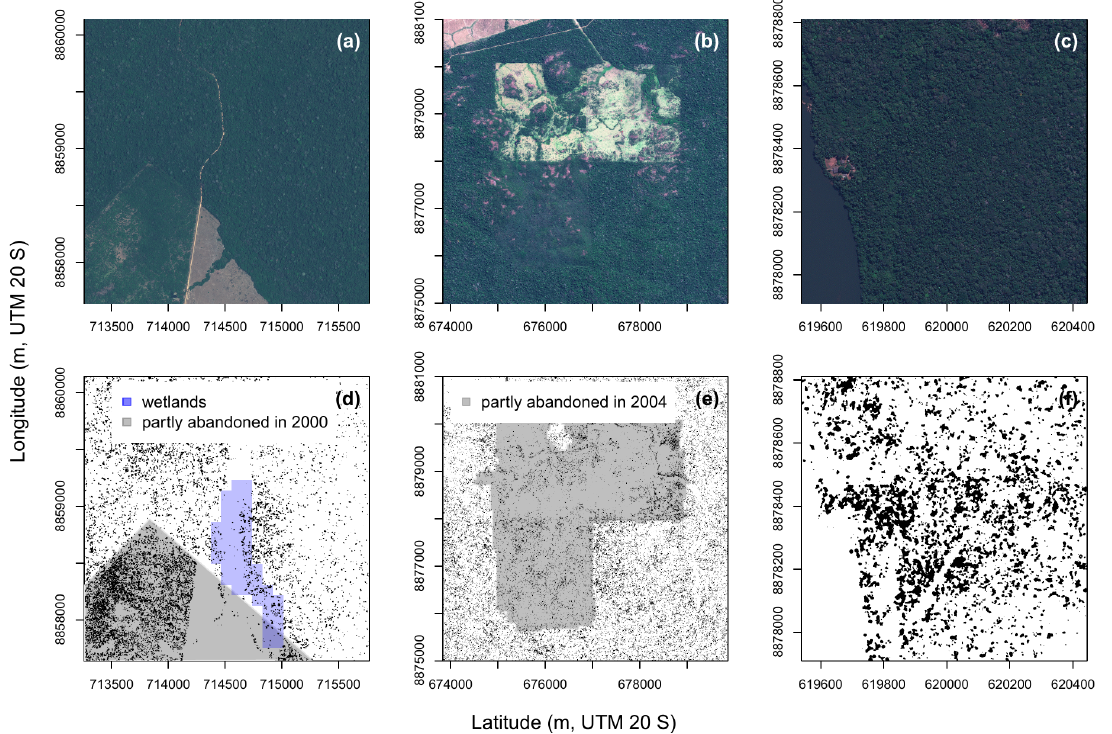
Figure 6. RGB image and distribution of canopy palms in 3 scenarios of forest degradation. Region 1 ( a , d ) was abandoned in 2000 after clear-cut before 1988 and maintained more than 10 years as a pasture, region 2 ( b , e ) was abandoned directly after clear-cut in 2002/2003 and region 3 ( c , f ) has no history documented of clear-cut since 1988 but had the presence of a human settlement. See Figure 5 for region